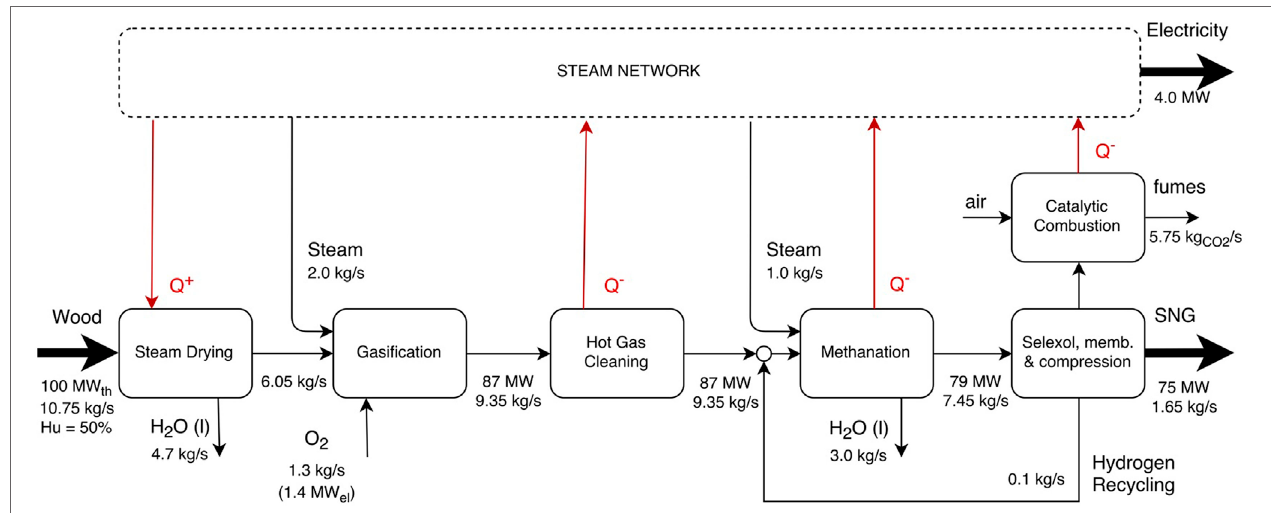
FigUre 1 | Flow diagram of a 100 MW th,wood gasification plant without cogeneration based on directly heated pressurized gasification system (Gassner and Maréchal,